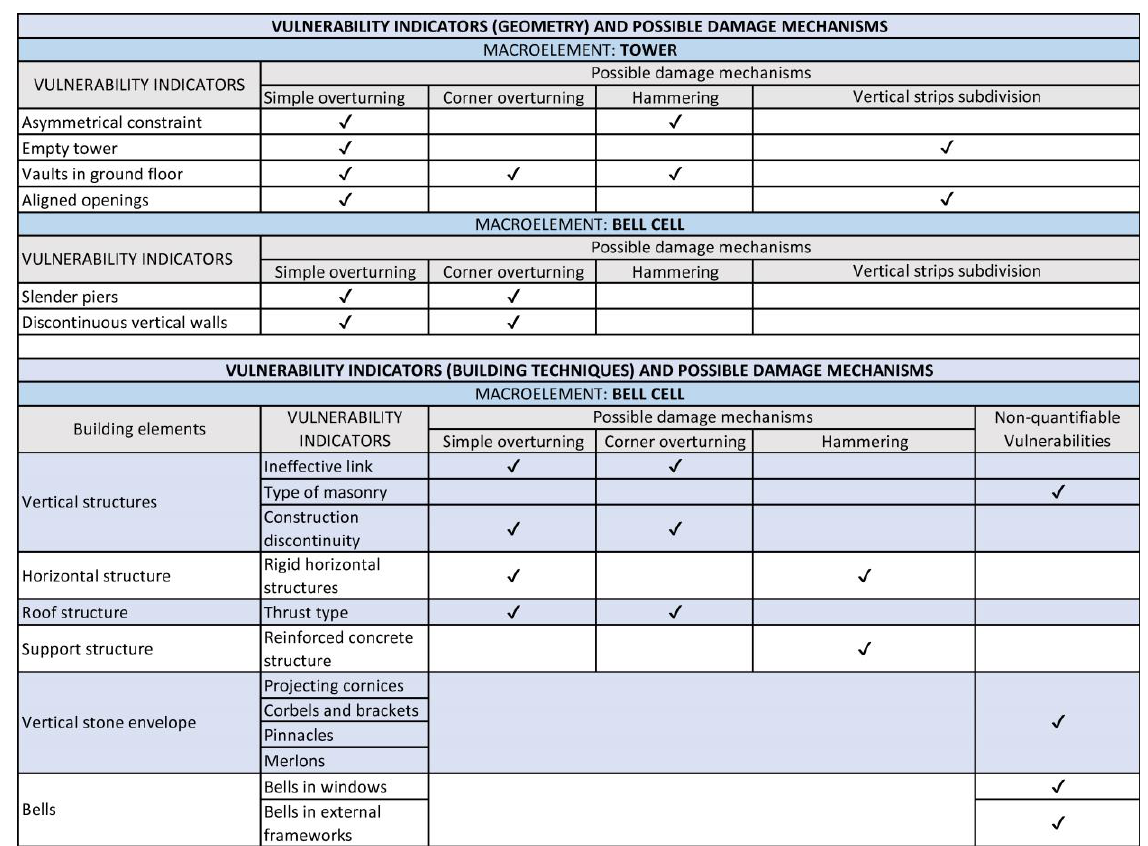
Figure 1. An offprint of the proposed check-list of the vulnerability indicators for the macroelements of the traditional bell